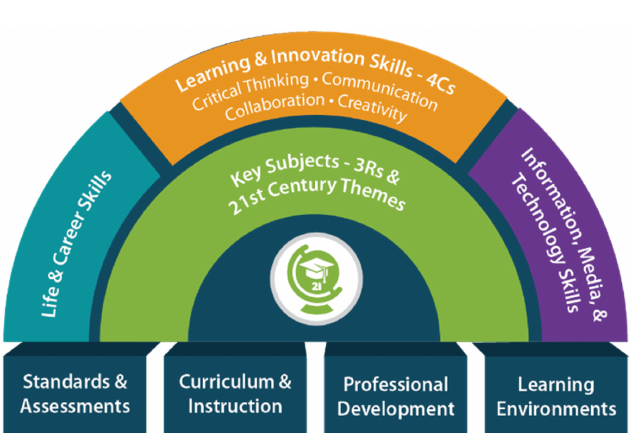
collaborative project output